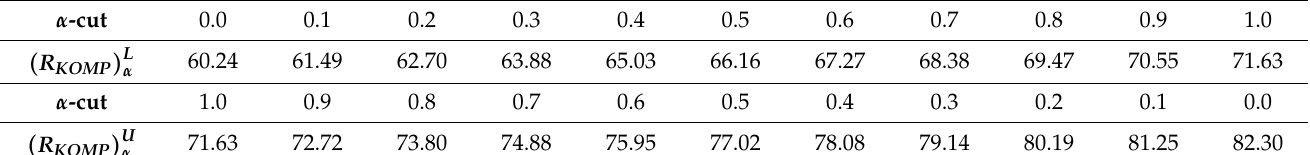
Table 11. The average of all combinations—the final fuzzy value of the substructure component rating.